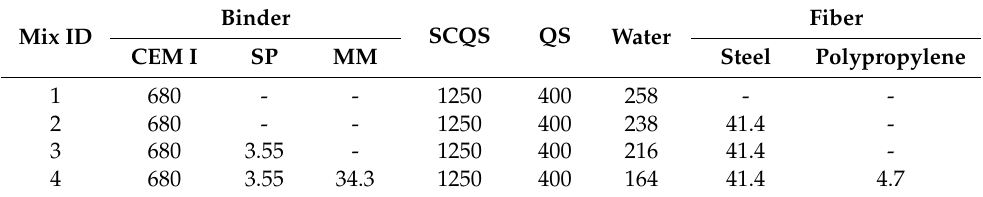
Table 2. Mix proportions, kg/m 3